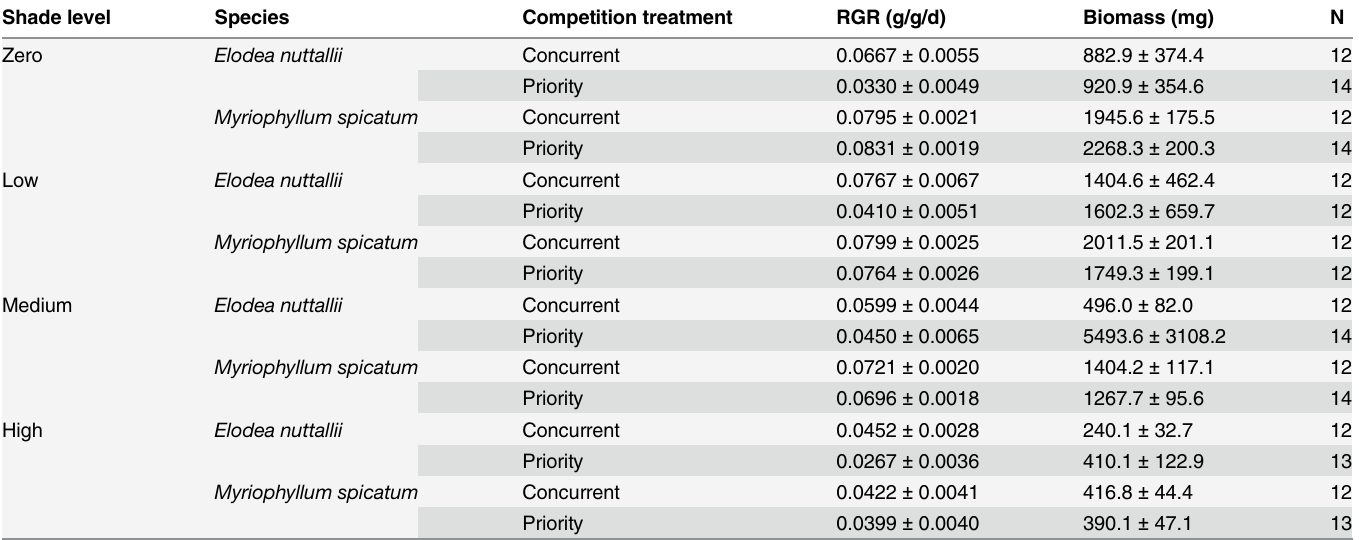
Table 2. Means, standard errors, and number of replicates for each species in each treatment combination. Shade level